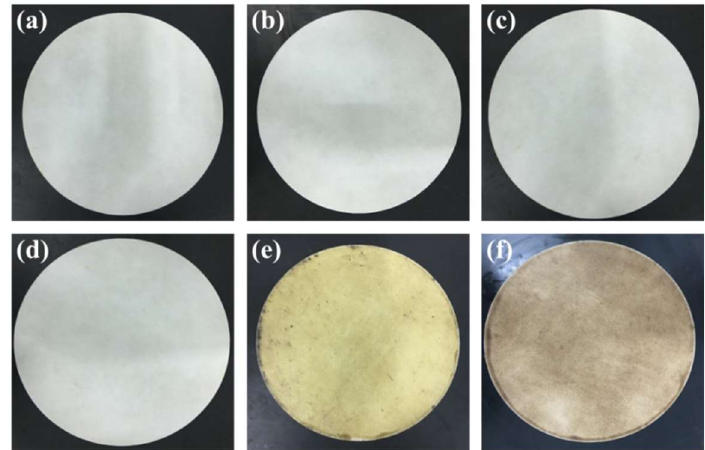
Figure 7. Illustration of SG polishing pad with different catalysts: ( a ) pristine pad, ( b ) synthetic soft abrasives, ( c ) citric acid, ( d ) theophylline, ( e ) green tea, and ( f ) coffee.